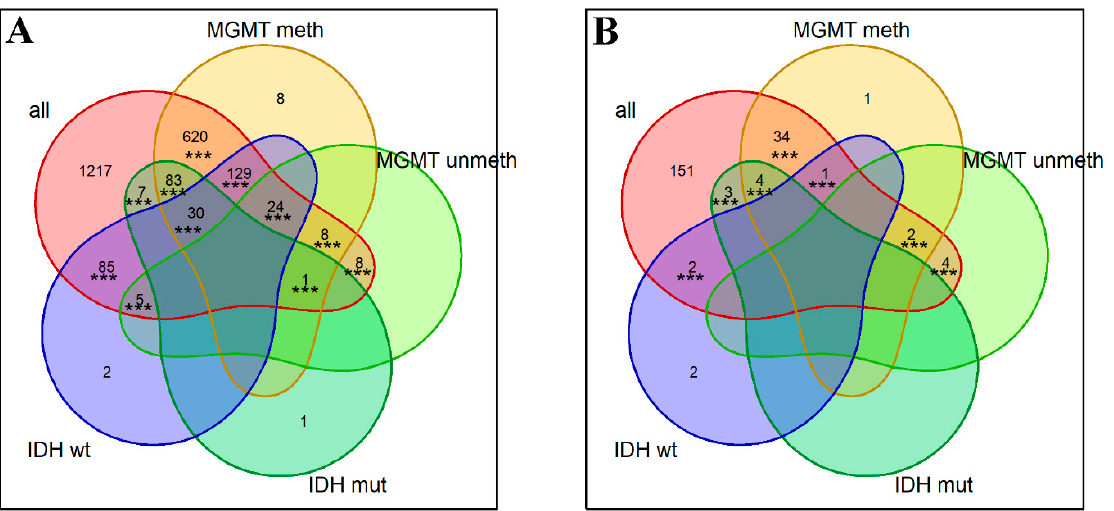
Figure 6. Numbers of gene-centric pathway biomarkers significantly associated with ( A ) shorter OS and ( B ) longer OS in the different LGG groups. Asterisks show significance levels of permutation testing for the respective intersections: *** for p < 0.001.